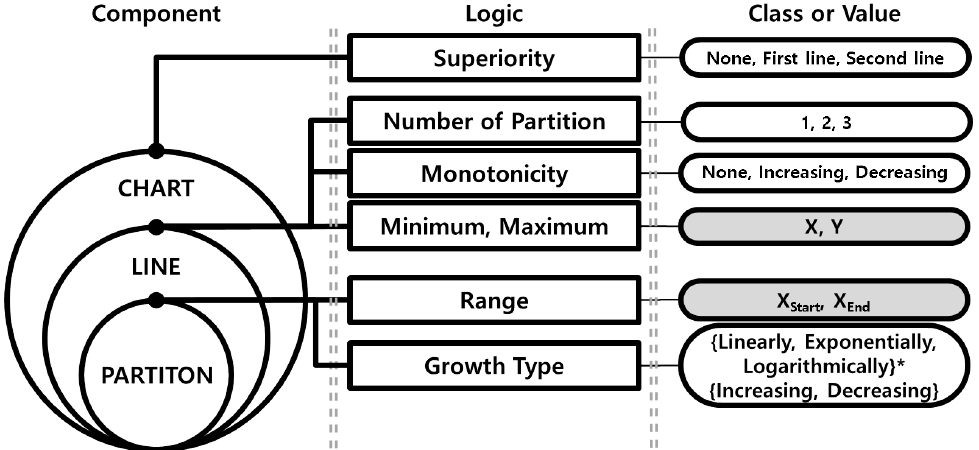
Figure 1. The structure of logic categories used as labels and their associated numerical ranges in the proposed knowledge template (white boxes in the third column are classification and grey boxes are regression